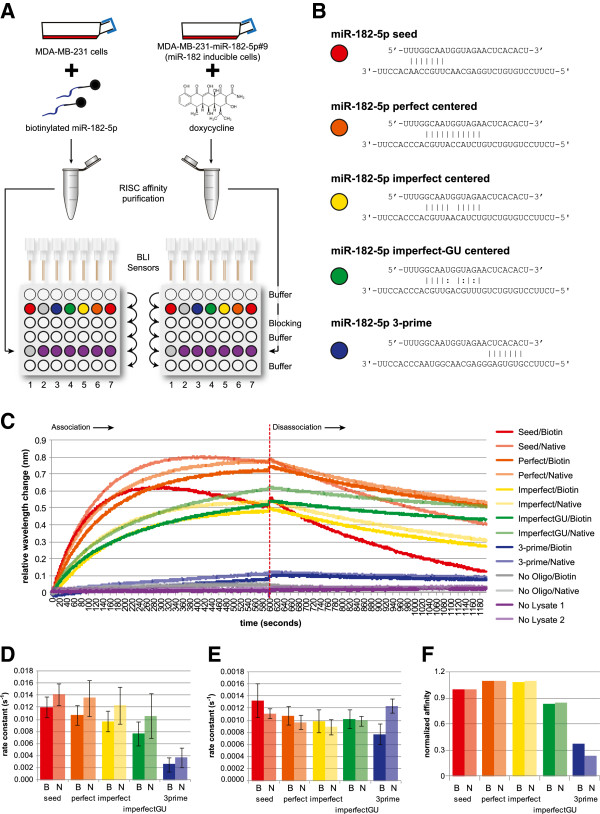
Biotin RISC differs only slightly from native RISC in affinity for centered sites. (A) Schematic diagram showing the bio-layer interferometry (BLI) experimental design. Cells were either transfected with biotinylated miR-182-5p or induced to over-express miR-182-5p, and RISC complexes containing these miRNAs were affinity purified. The two RISC solutions were used in parallel BLI runs to detect association and disassociation with RNA oligos containing the binding sites. The arrows indicate the sequential immersion of the sensors in a row. Lane 1, no lysate; lane 2, no oligo; lane 3, miR-182-5p 3 prime binding site; lane 4, miR-182-5p imperfect centered site with GU wobble; lane 5, miR-182-5p imperfect centered site; lane 6, miR-182-5p perfect centered site; lane 7, miR-182-5p seed site. (B) The binding between miR-182-5p and the RNA oligo is illustrated. The miRNA is depicted on the top strand, and the binding site in the oligo on the bottom strand. Perfect Watson-Crick matches are indicated with the vertical line, and GU wobble sites by a colon. (C) A representative association/disassociation curve from the BLI showing the wavelength interference (nm) versus time. The dashed line indicates the time at which the BLI sensors were removed from the RISC solution and transferred to buffer. (D) Rate constants for association were calculated independently from four biological replicates, and plotted separated for biotin RISC (B) and native RISC (N) across all five binding sites. Error bars represent standard error of the mean (sem). (E) Rate constants for disassociation were calculated and plotted as for (D). Error bars represent standard error of the mean (sem). (F) The normalized affinity for each site type was calculated by dividing the association rate constant by the disassociation rate constant, and normalizing all site types to the ratio for the seed site. This shows that, with the exception of 3' sites, the relative affinities between biotin RISC and native RISC are essentially equivalent.